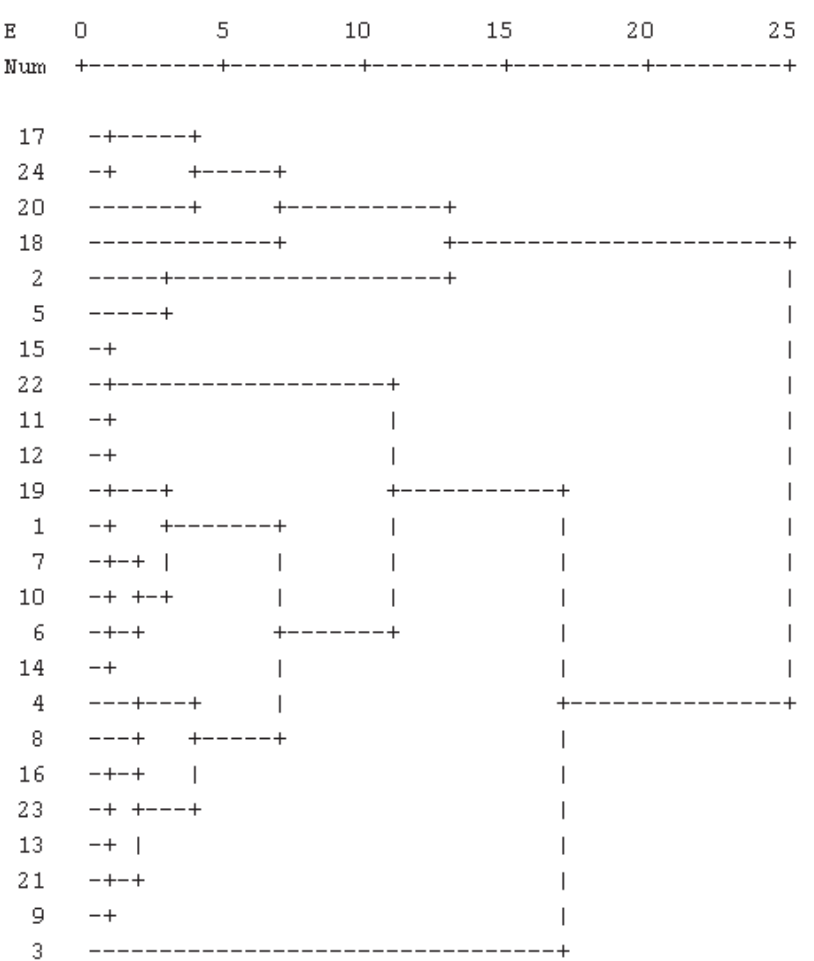
Fig. 1. Dendogram of athletes incorporation in clusters: Rescaled Distanse Cluster Combine – is a scale of the conventional differences between examinees in case of their incorporation; Num – is the conventional number of the